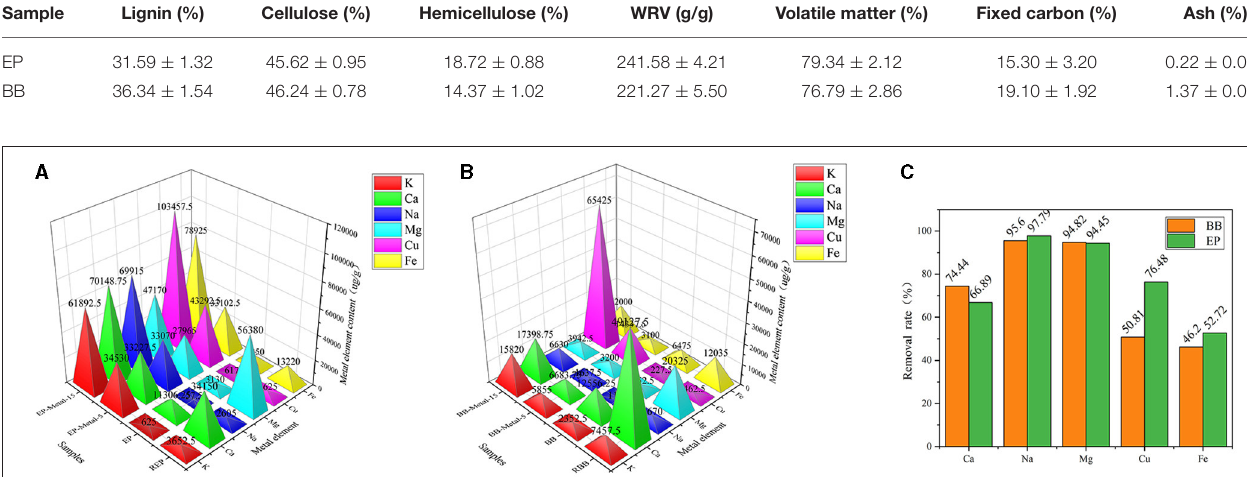
TABLE 1 | Composition analysis of raw materials. Sample